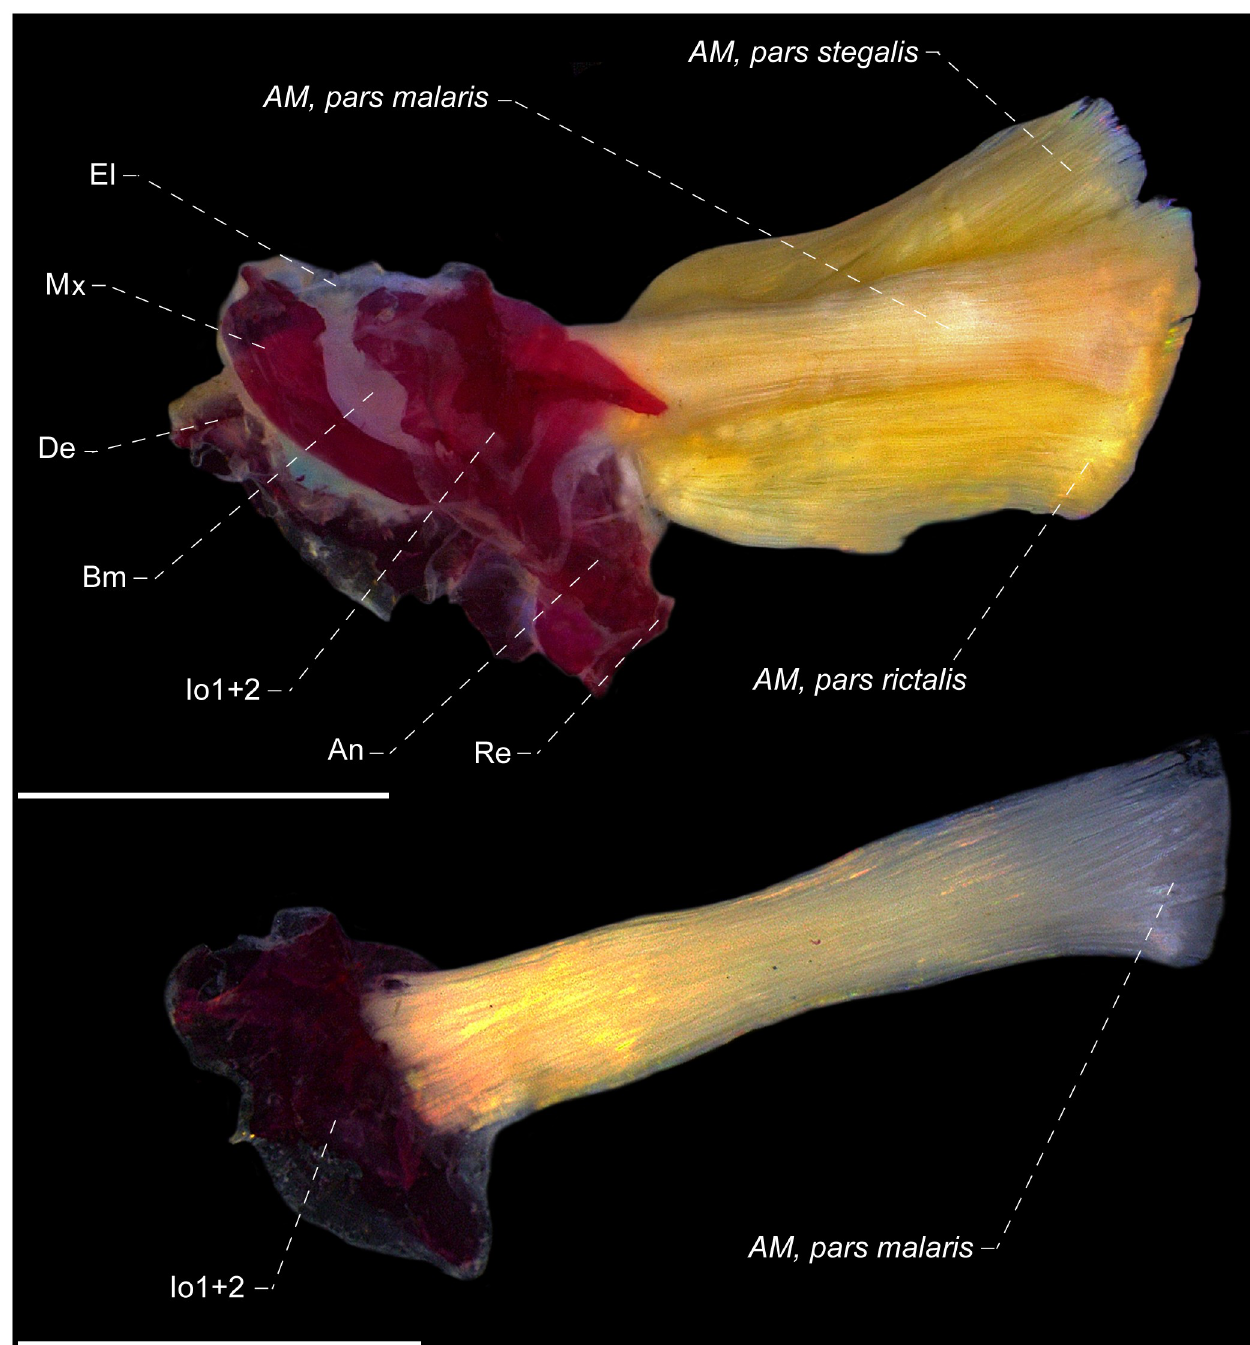
Fig 11. Lateral view of adductor mandibulae , segmentum facialis (A) and medial view of adductor mandibulae , pars malaris (B) of Sternopygus astrabes , MZUSP 88795, 151.0 mm L EA . Am = adductor mandibulae ; An = anguloarticular; Bm = buccopalatal membrane; De = dentary; El = endomaxilar ligament; Io = infraorbital; Mx = maxillary bone; Re = retroarticular. Endomaxilar ligament and buccopalatal membrane dissected. Scale: 3 mm.